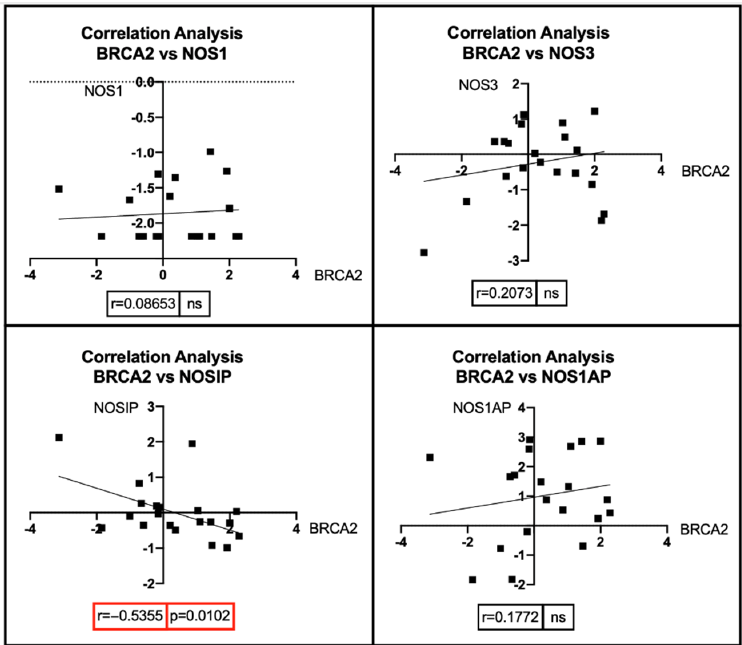
Figure 6. Correlation analyses between the expression levels of BRCA2 and NOS genes in TCGA breast cancer patients with mutations affecting BRCA2. Each black square represents a cancer patient. The correlation analyses between the expression levels of BRCA1 and NOS genes revealed how the expression levels of dysregulated BRCA1 due to somatic mutations positively correlate with the expression levels of NOS1 (r = 0.5191; p = 0.0078), while no significant correlations were observed between BRCA1 and NOS3 , NOSIP , and NOS1AP (Figure 7).